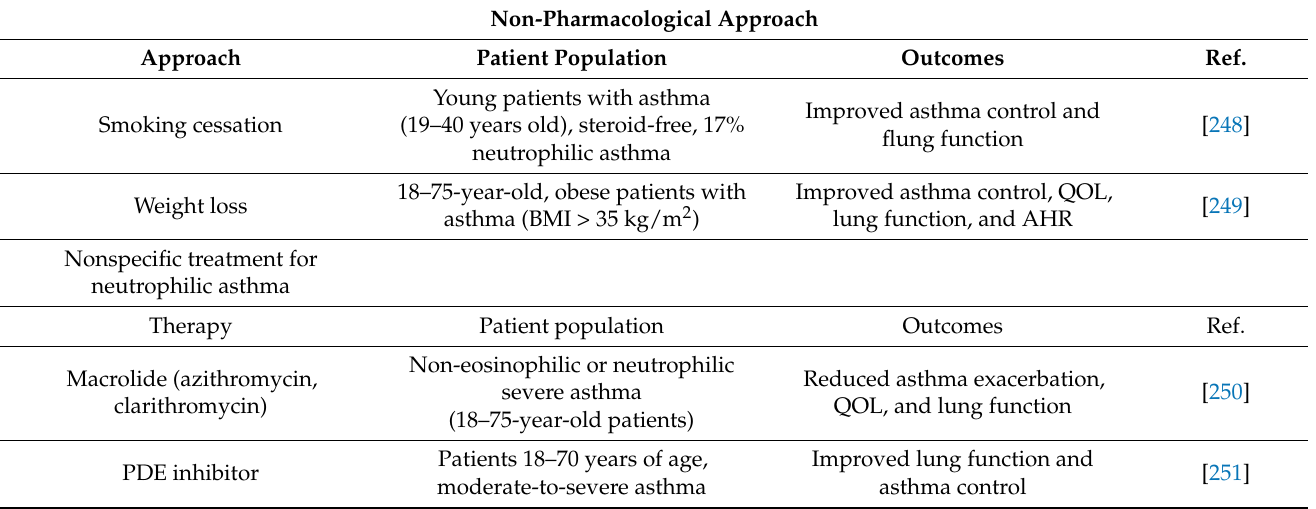
Table 2. Summary of treatment for asthma related to neutrophilic